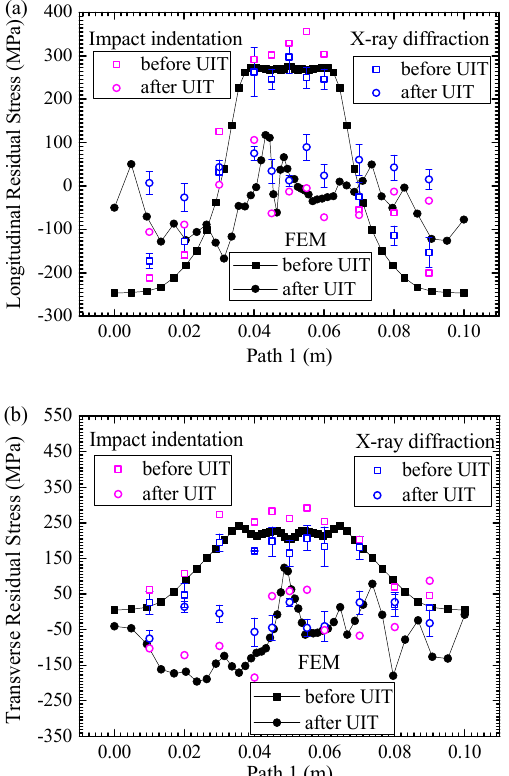
Figure 9. Comparison of longitudinal ( a ) and transverse residual stresses ( b ) before and after UIT by experiment and FEM along Path 1. experiment and FEM along Path